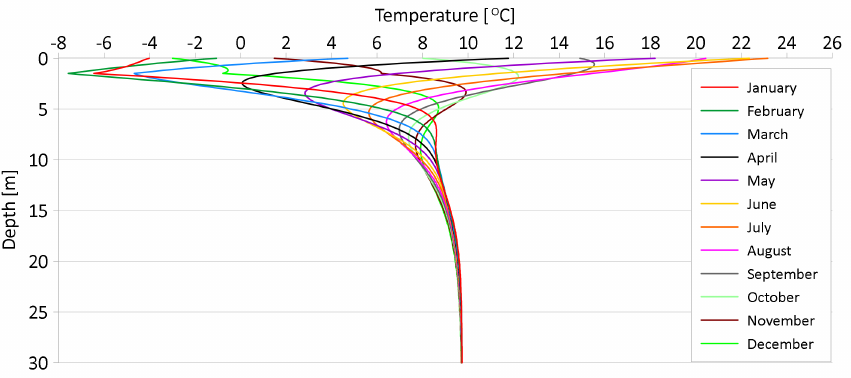
Figure 3. Ground temperature profiles with a heat exchanger installed for individual months of the year; k = 1.4 W/ ( mK ) ; q max = 15 W/m 2 ; κ = − 1.